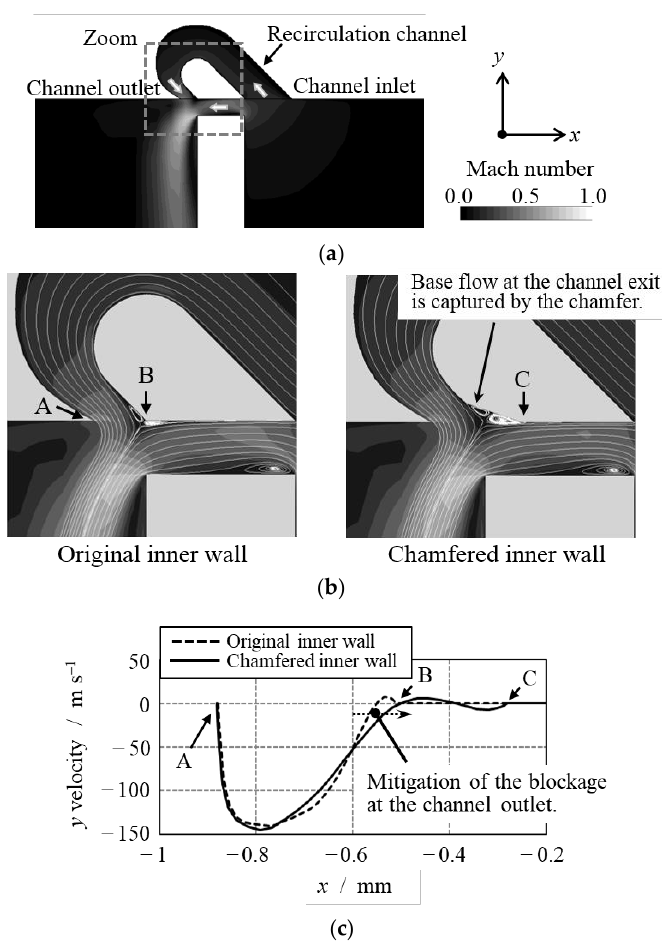
Figure 4. Application of a chamfer on the RC inner wall edge showing the mitigation of the blockage at the channel outlet. ( a ) Overview of the recirculation channel flow structure. ( b ) Improving the inner float shape. ( c ) Comparison of the y velocity distribution at the recirculation channel outlet.